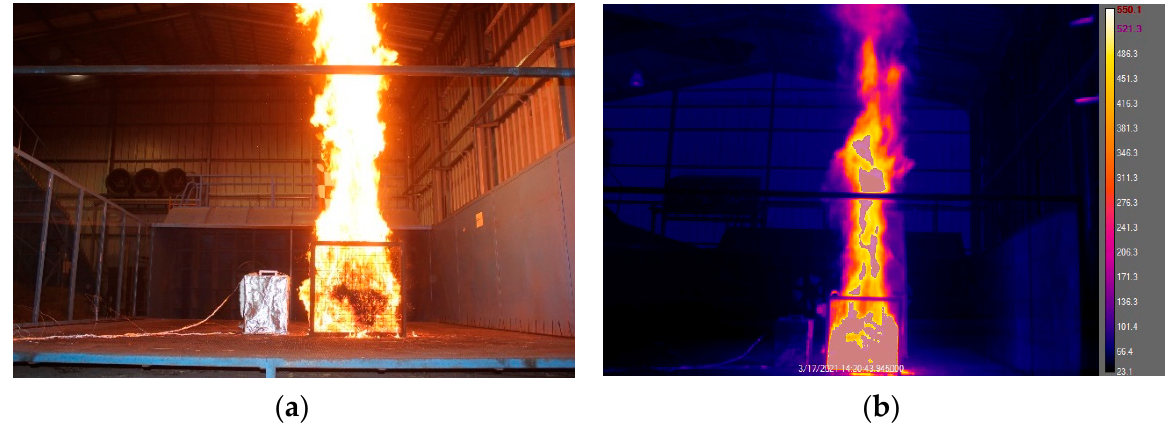
Figure 3. Laboratory test (PS025) at 0.25 m from the basket fuel: ( a ) video and ( b ) InfraRed camera image.